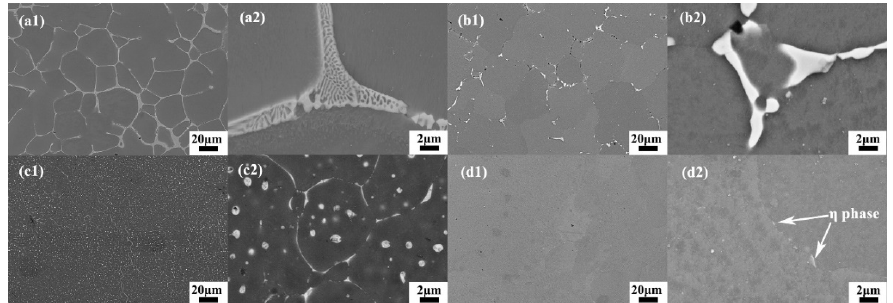
Figure 49. SEM images of: ( a ) Cast, ( b ) T6 heat-treated cast sample, ( c ) as-prepared SLM and ( d ) T6 heat treated SLM samples [183]. Copyright 2016. Adapted with permission from Elsevier Science Ltd.